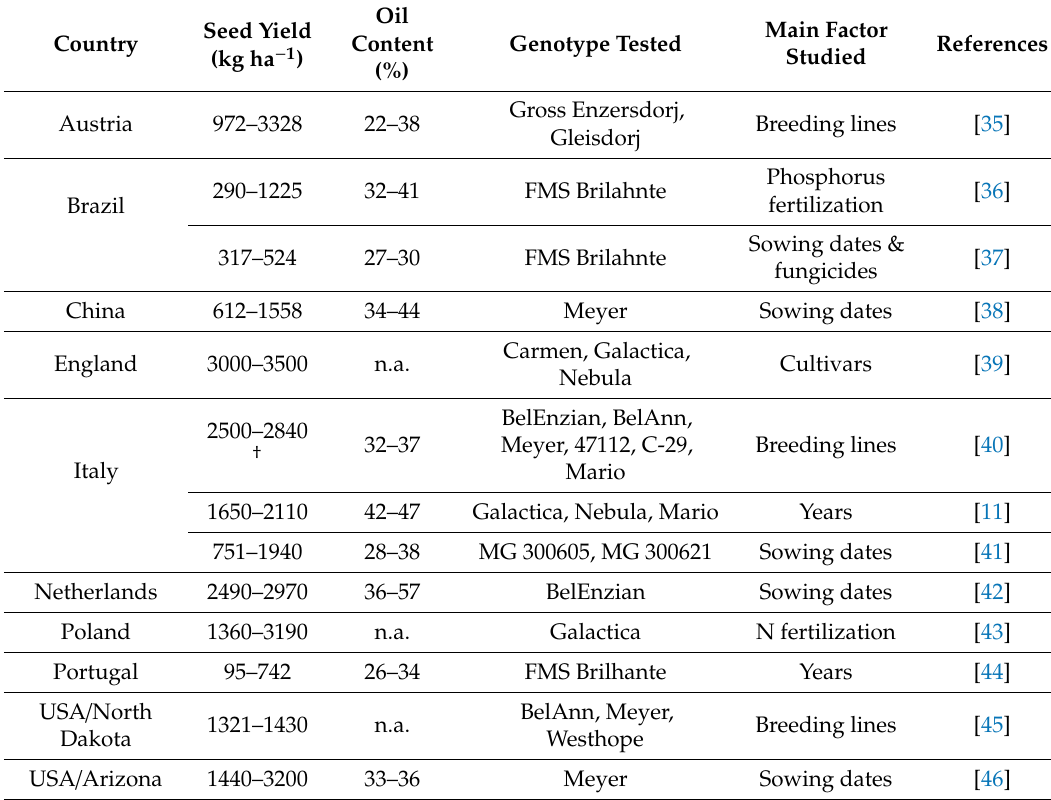
Table 2. Crambe seed yield and seed oil content as reported in the reviewed literature under di ff erent environmental